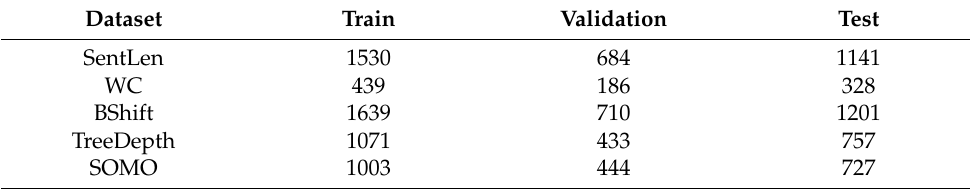
Table 4. Probing task datasets.